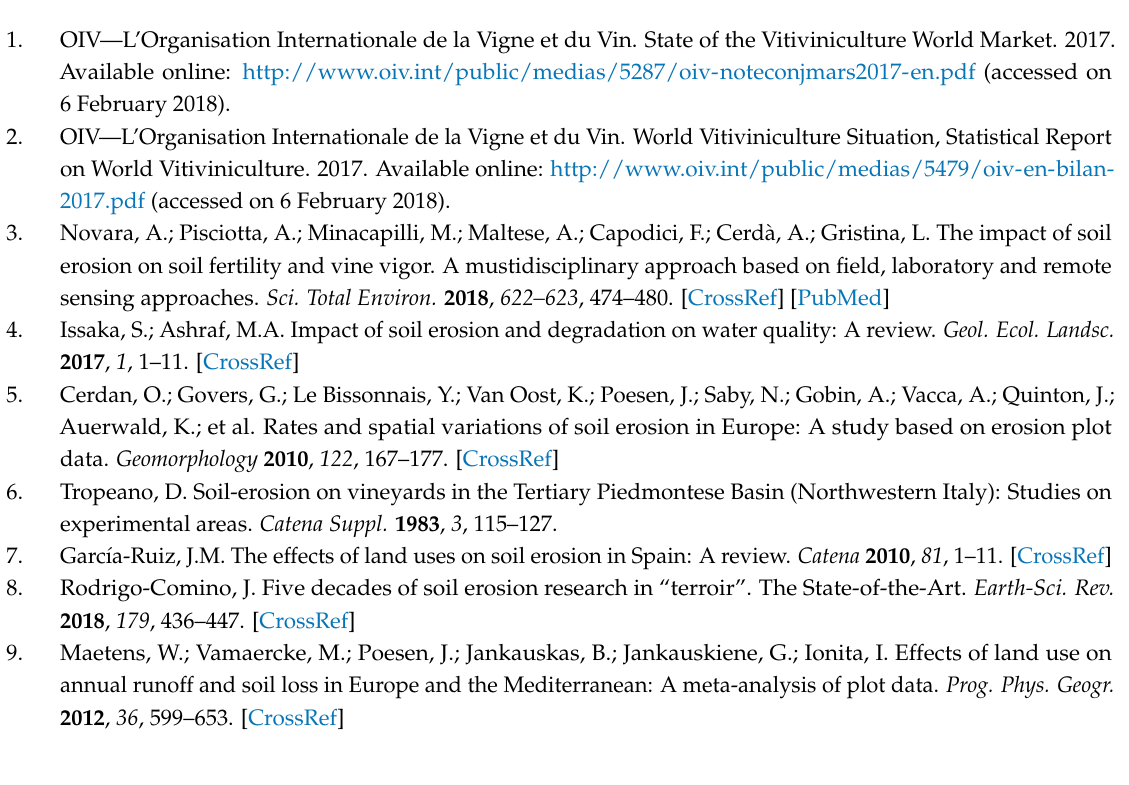
s1, Figure S1: Correlation between the minimum (a) and maximum (b) relative differences ( δ it ) of TSWC during the 15-month test period, and the average value of monthly TSWC ( θ 0 , % vol.) in the four vineyards, Figure S2: Evolution of the observed values of runoff (Q) and sediment (SY) yields in the two sediment traps (ST) during the 15-month test period. The average sediment concentration is also